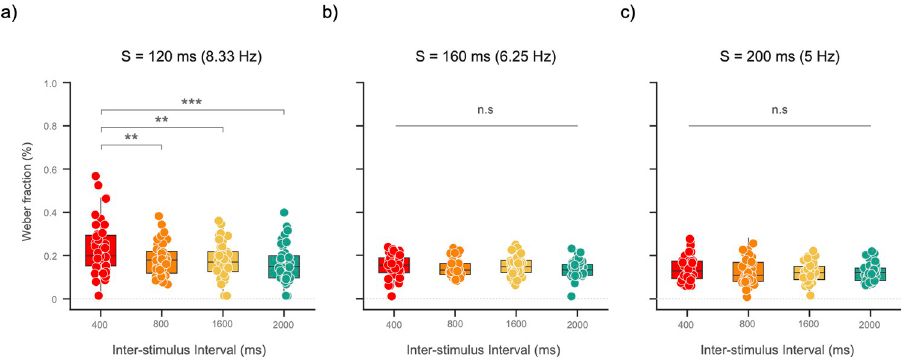
Fig 2. Sensory precision stabilizes at longer Standard events. Box-and-whisker plots show the distribution of the Weber fractions (WF) for each ISI level in each S duration. The bottom and top edges indicate the interquartile range (IQR), whereas the median is represented by the horizontal line. The extension of the whiskers is 1.5 times the IQR. Boxplots are overlaid with data of each participant. a) For a 120-ms S, results showed a significant effect of ISI: Temporal sensitivity increased for ISIs � 800 ms, as reflected by lower WF values in the ISI 800 , ISI 1600 , and ISI 2000 conditions. b) The effects of ISI disappeared for a 160-ms S. c) The same was true for a 200-ms S, as no changes between ISI levels were detected. ( ��� = p -value < 0.001; �� = a p -value < 0.01; and ‘n.s.’ = a non-significant result with a p -value �